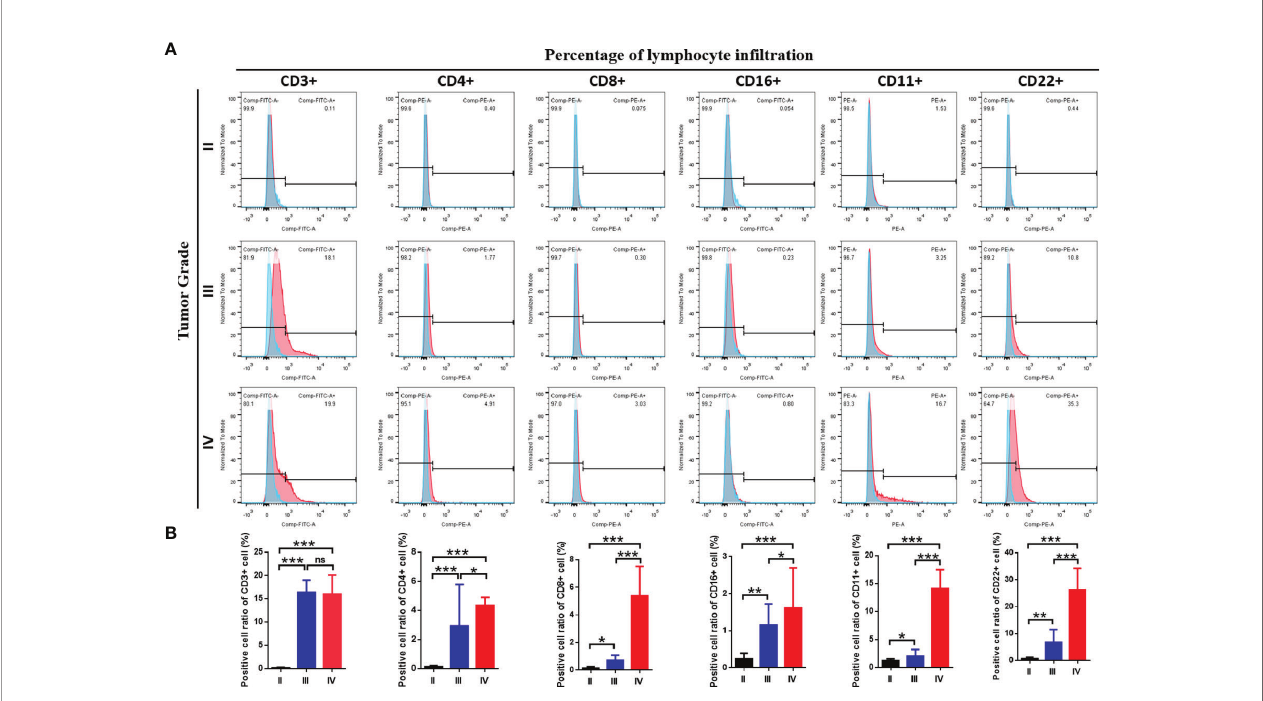
FIGURE 4 | The immune cells in fi ltration among three grades of glioma. (A) Flow cytometry results showed the abundance of each 6 types of in fi ltrating cell in three grades and (B) the results of statistical analysis showed the proportion of cell in fi ltration.*P ≤ 0.05, **P ≤ 0.01, ***P ≤ 0.001. ns, no signi fi cance.